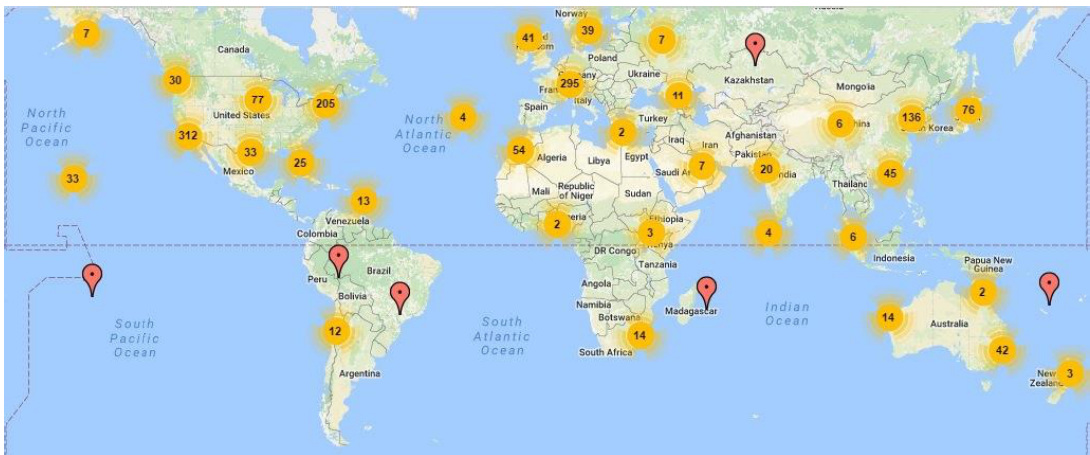
Figure 2. A worldwide snapshot of approximately 1600 energy storage projects with total capacity of 193 MW as in August 2016 (adopted from DOE [4], with permission from STRATEGEN Consulting and Sandia, 2016).